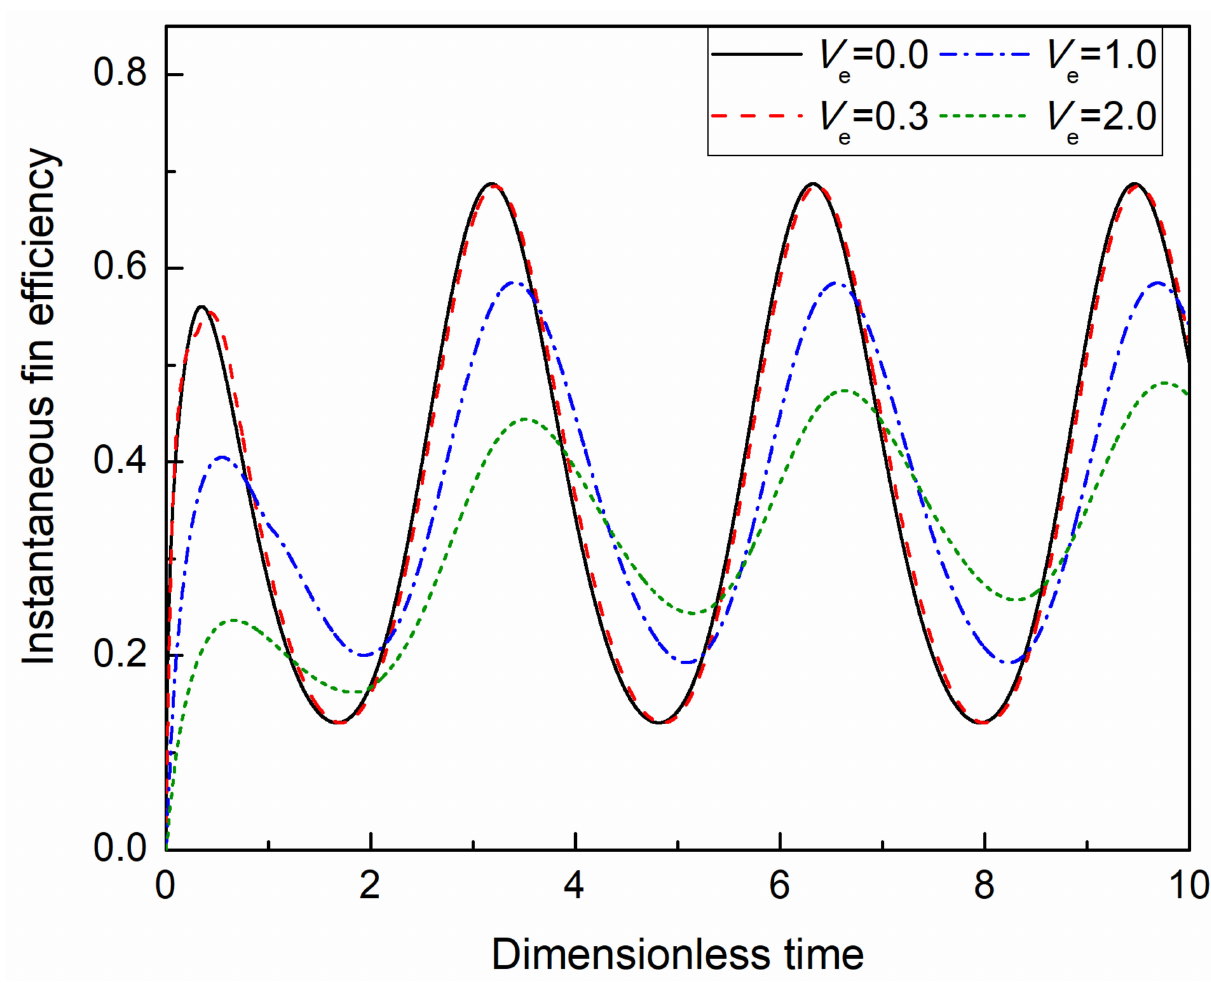
Figure 7. The variation of instantaneous fin efficiency at different values of V e